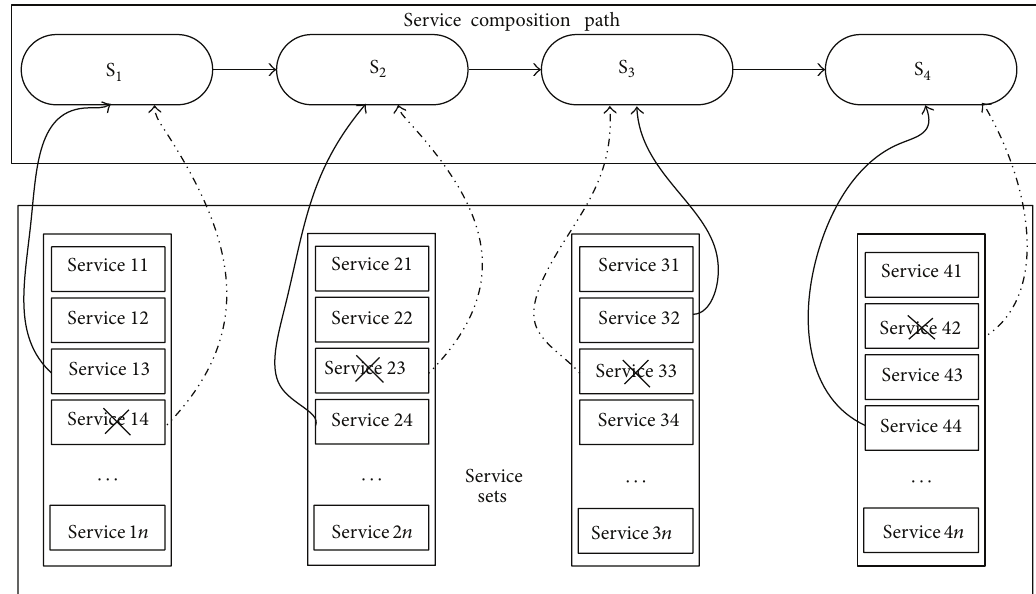
Figure 4: Failed service instead